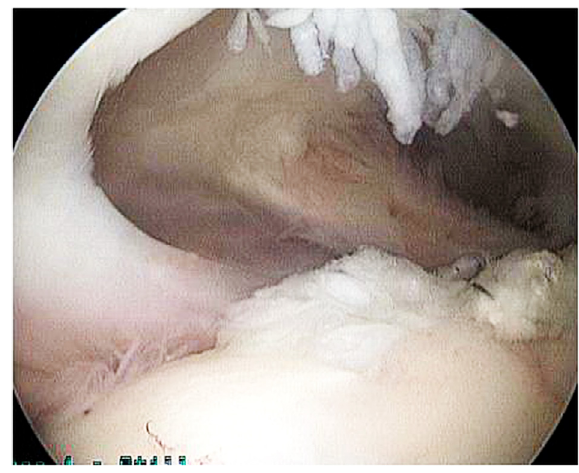
Figure 1. The supraspinatous tendon is frayed and inflamed.